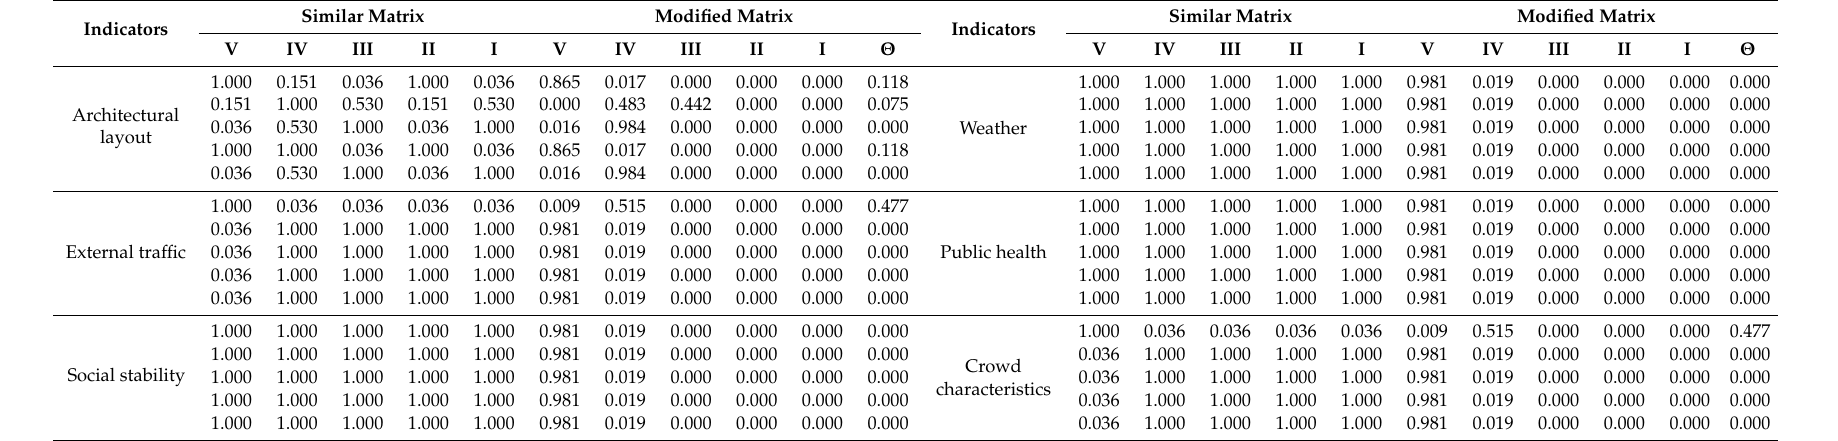
Table A2. Results of similar matrix and modified